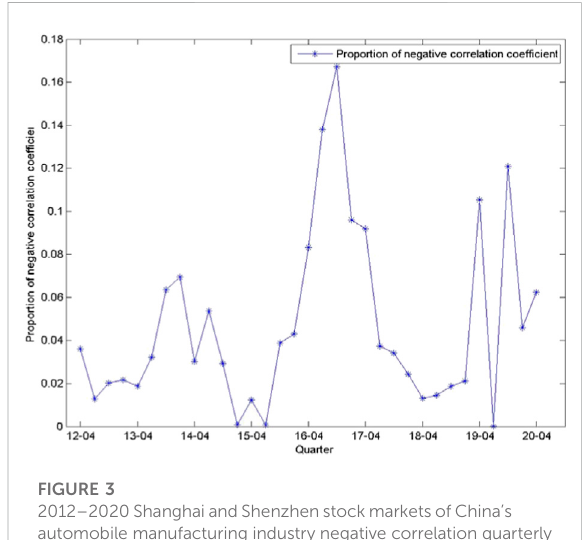
FIGURE 3 2012 – 2020ShanghaiandShenzhenstockmarketsofChina ’ s automobile manufacturing industry negative correlation quarterly changes.